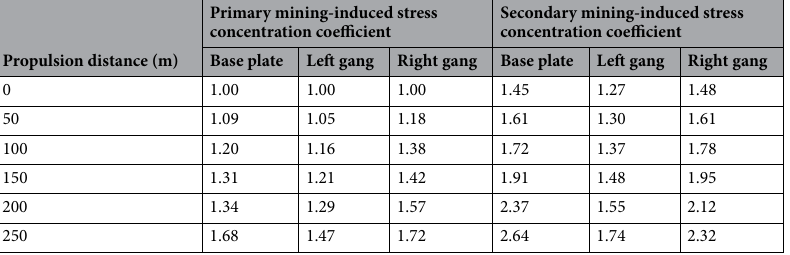
Table 4. Change in the stress concentration coefficient of the 2603 air inlet roadway caused by mining.